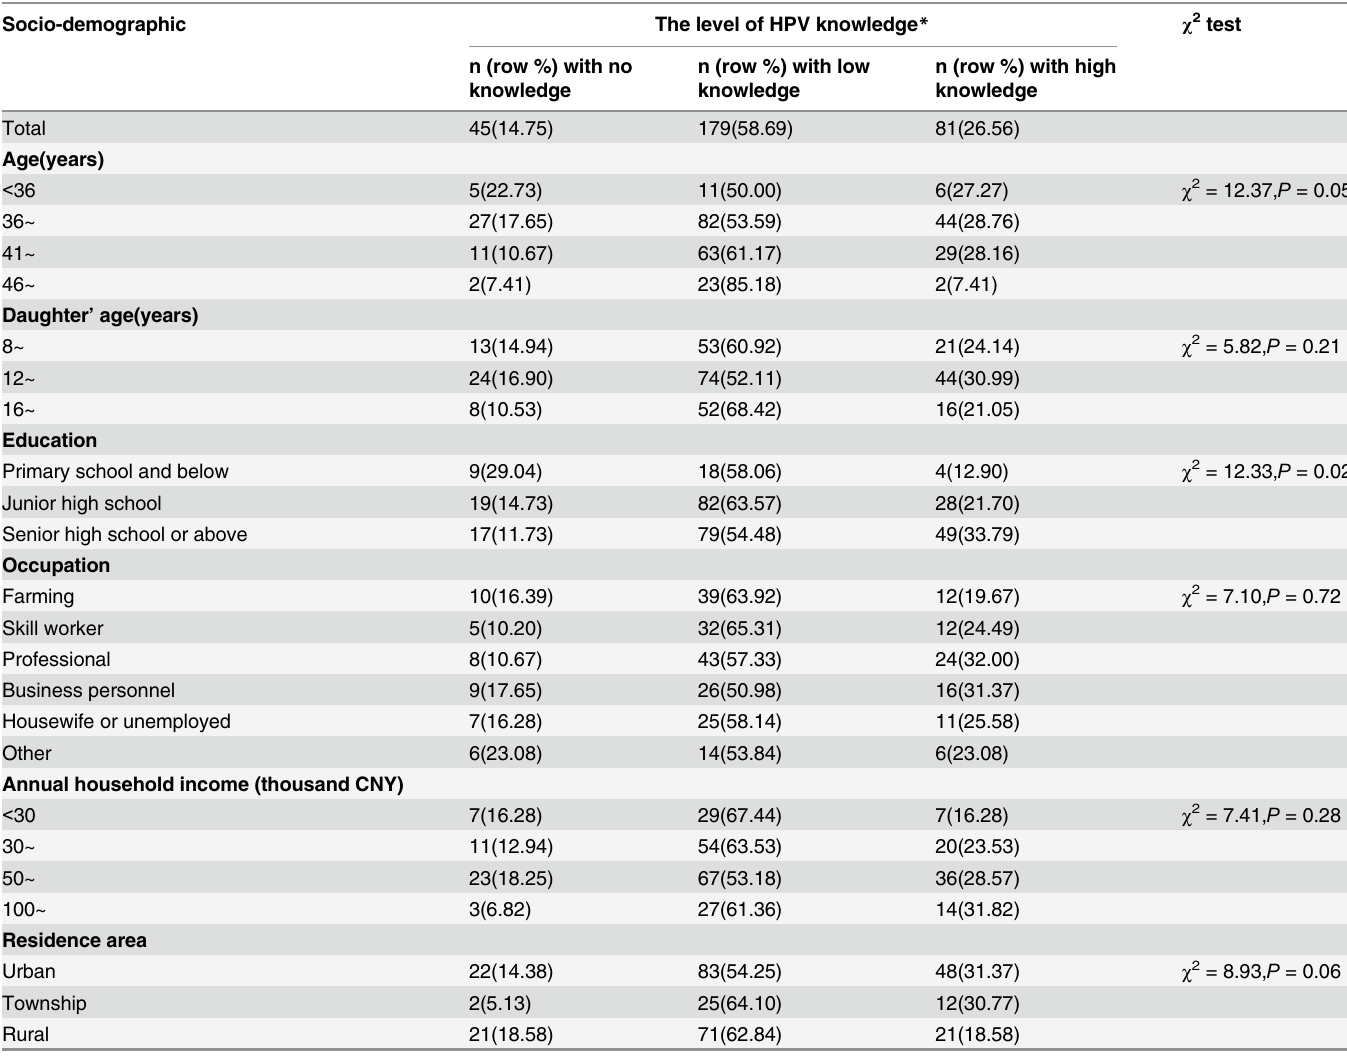
Table 3. The level of HPV knowledge by socio-demographic characteristics (n =